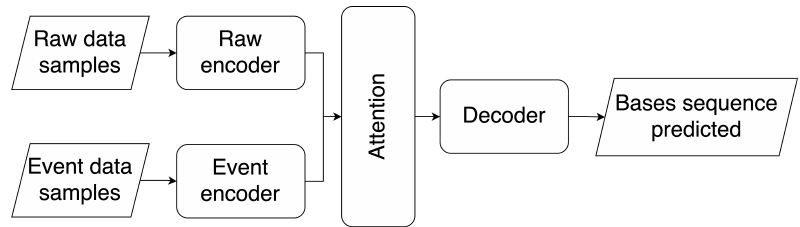
Figure 5. Schematic representation of model